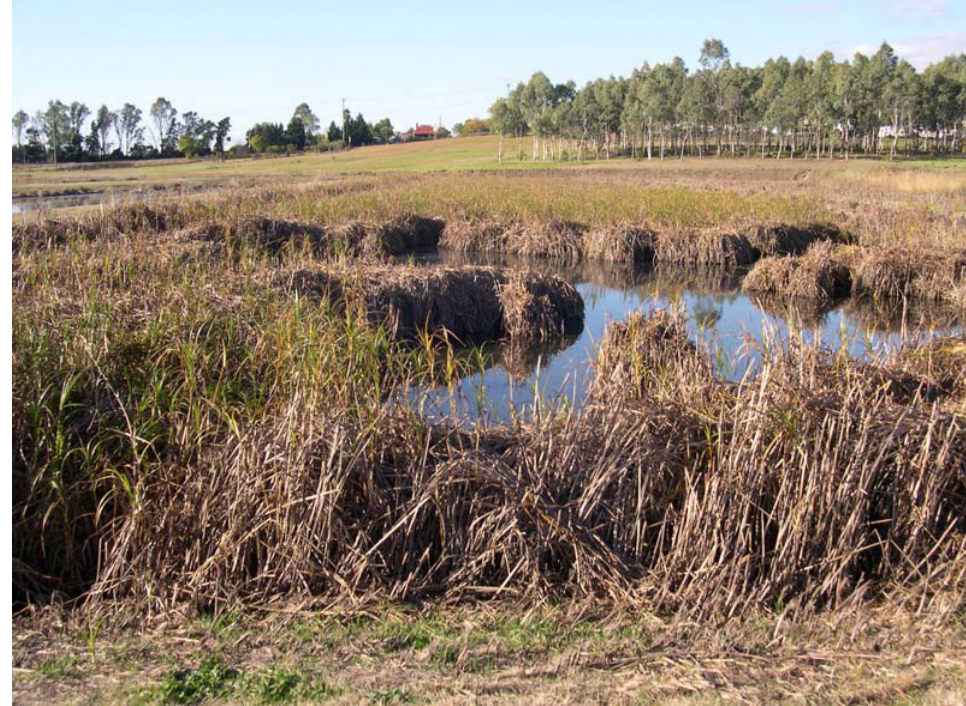
Figure 4. A FWS CW for tertiary treatment of municipal wastewater in McGrath Hill, Hawkesbury, near Sydney, NSW, Australia. Photograph taken by the